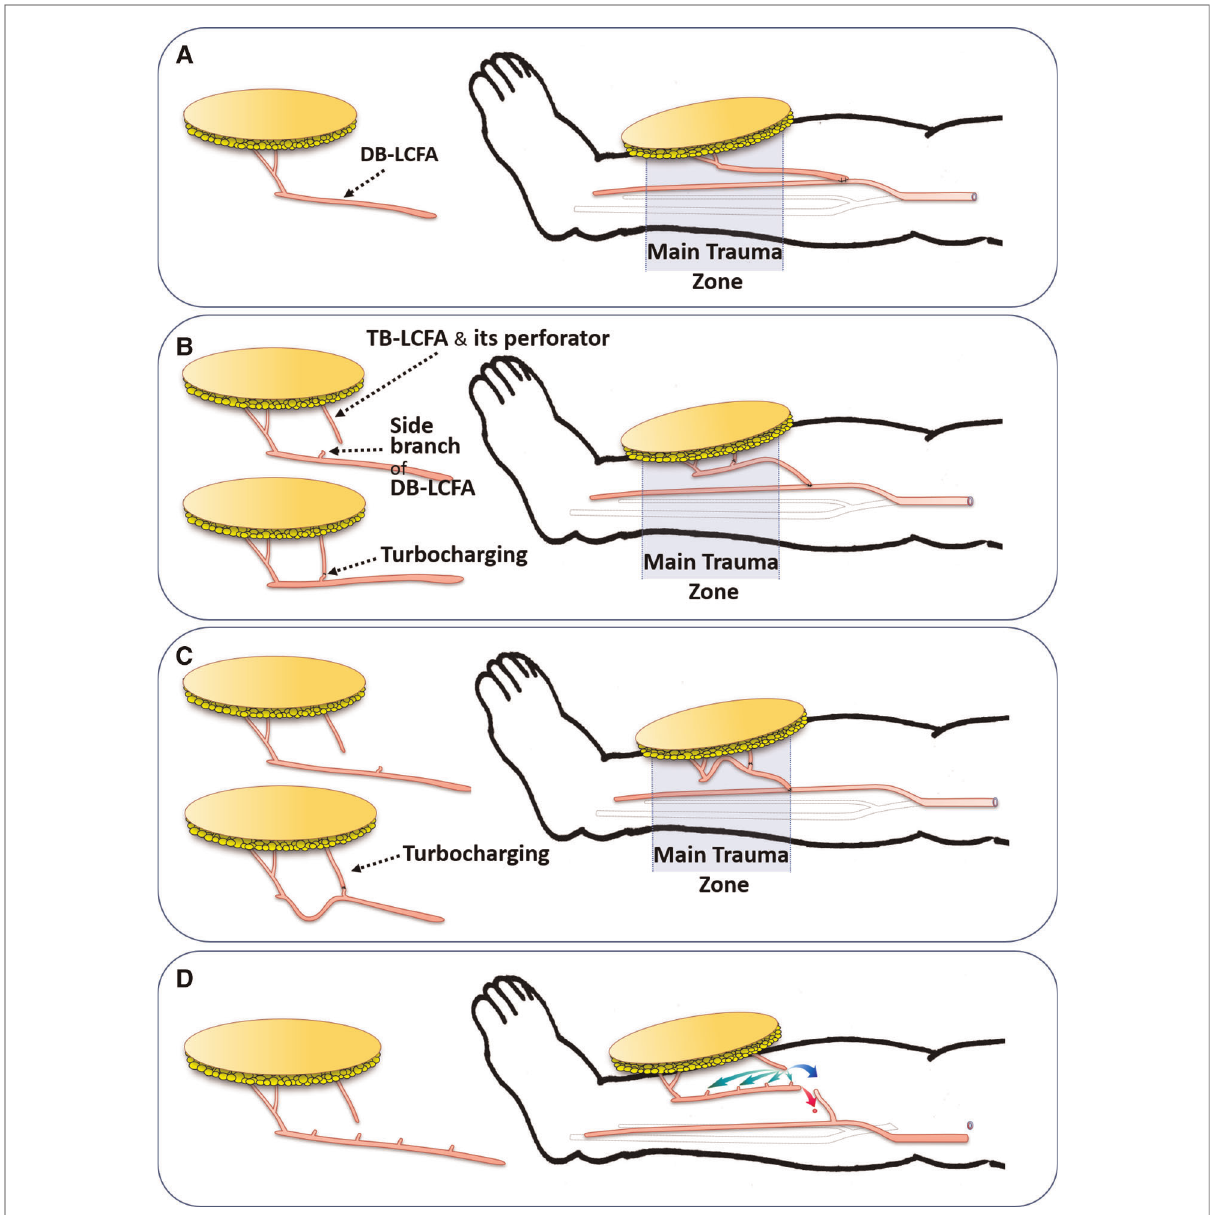
FIGURE 5 The effects of the turbocharging procedure on the main pedicle (DB-LCFA) length according to the timing of the procedure (Pre-or Post-harvest). ( A ) Without the turbocharging procedure, the transferred ALTP fl ap probably has great mobility of the main pedicle, enabling tension-free insetting of the fl ap. ( B ) With the turbocharging procedure, the length of the main pedicle possibly is shortened, and the mobility of the fl ap may be somewhat limited because of the fi xation effect of the turbocharged vessel. ( C ) When the TB-LCFA is connected to the proximally located side branches of DB- LCFA, the main pedicle length may be critically shortened, precluding the main pedicle anastomosis from being performed proximal to the zone of injury. ( D ) In worrisome cases in which critical shortening of the main pedicle following the turbocharging procedure may occur, the ALTP fl ap is harvested and transferred without the turbocharging procedure. Next, the main fl ap pedicle is anastomosed to the recipient vessel in advance (red arrow). Then, the turbocharging procedure is attempted after appropriate preparation of the TB-LCFA and side branches of the DB-LCFA (green arrow). If it is impossible due to problems in the length or location of the vessels, vessel grafts or anastomosis between TB-LCFA and a side branch of the recipient ’ s vessel (supercharging procedures; blue arrow) can be used to overcome those problems. DB-LCFA,